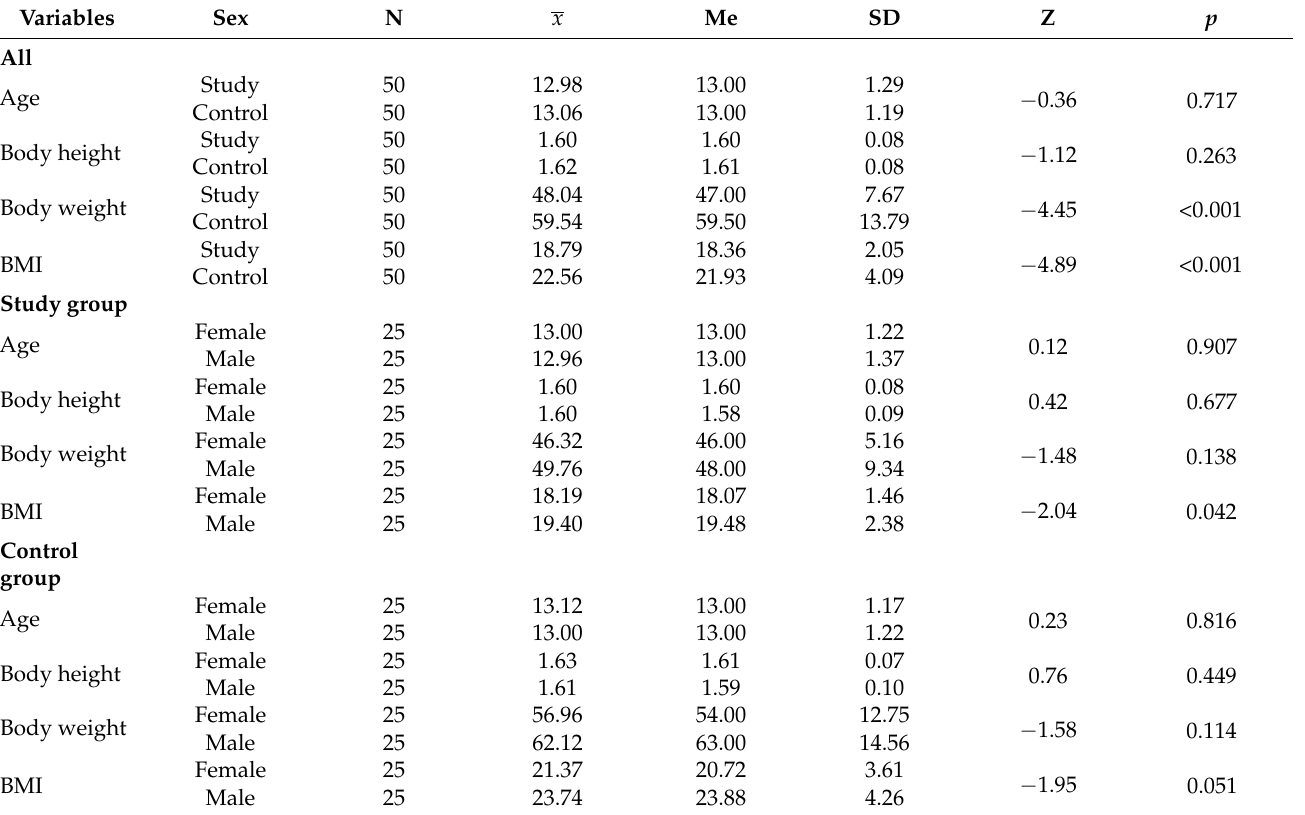
Table 7. Comparisons of age, weight, height and BMI between girls and boys in the study and control